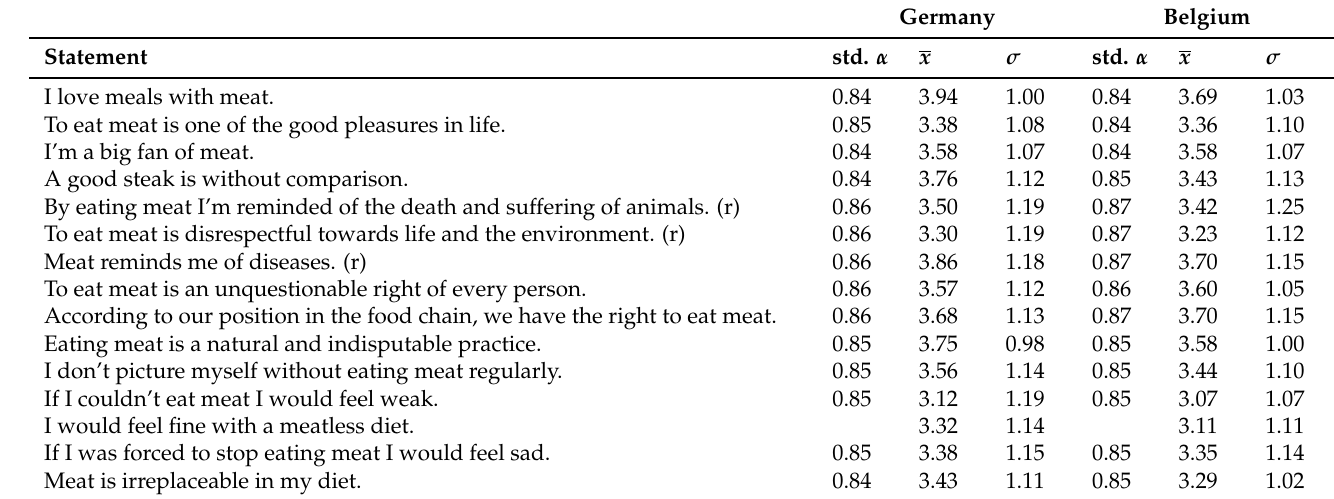
Table 5. Meat Attachment Scale (MEAS) questionnaire.